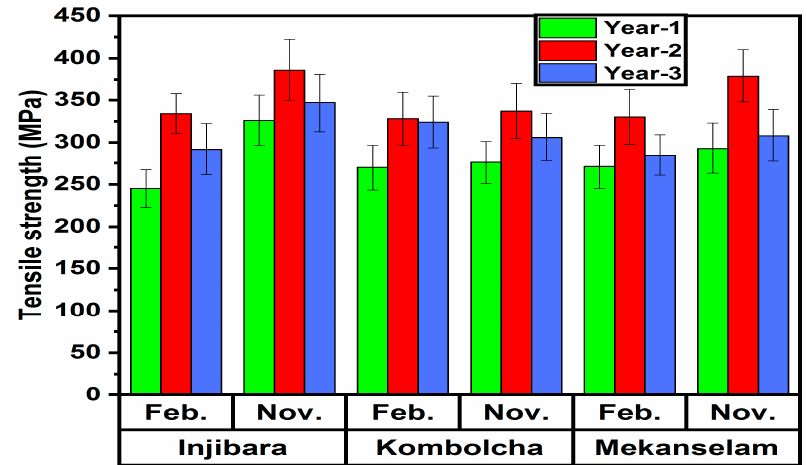
Figure 9. Back calculated tensile strength of the bamboo fibre in Ethiopia from BFRPPCs.